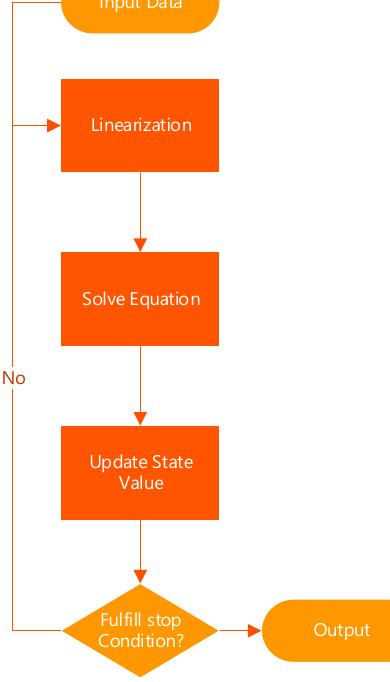
Figure 9. The Flow chart of Optimization.